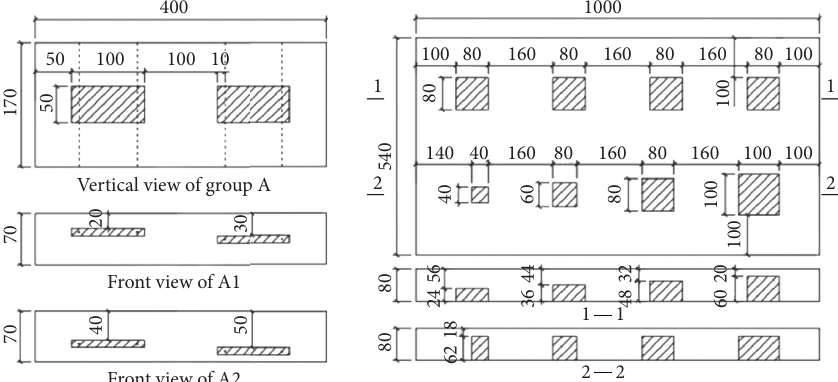
Figure 1: Defect layout of specimens.